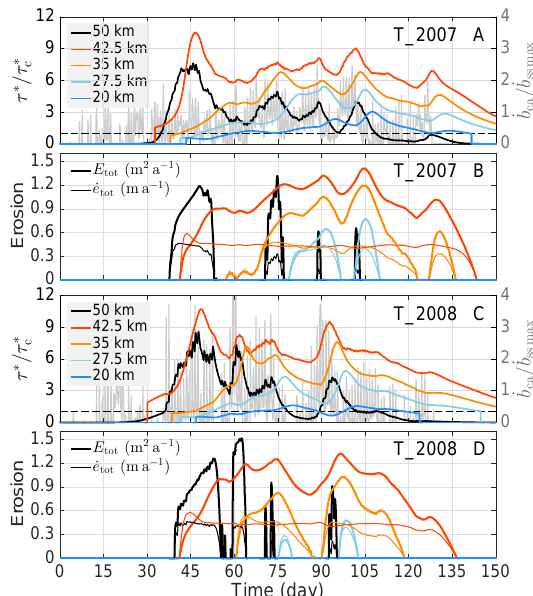
Figure 6. Time series of transport stage and erosion rates for two realistic water input time series (Table 4, T_2007 and T_2008) at five different distances from the divide (km 20, 27.5, 35, 42.5, and 50). (a) Transport stage ( τ ∗ /τ ∗ c ) and normalized meltwater input ( ˙ b ca / ˙ b ssmax ) at the terminus (light grey) for simulation T_2007. (b) Erosion rate per unit width ˙ e tot (thin lines) and total ero- sion E tot (thick lines) for simulation T_2007. (c) Transport stage ( τ ∗ /τ ∗ c ) and normalized meltwater input ( ˙ b ca / ˙ b ssmax ) at the termi- nus (light grey) for simulation T_2008. (d) Erosion rate per unit width ˙ e tot (thin lines) and total erosion E tot (thick lines) for simula- tion T_2008. The dashed lines in (a) and (c) represent the threshold for sediment motion: τ ∗ /τ ∗ c =